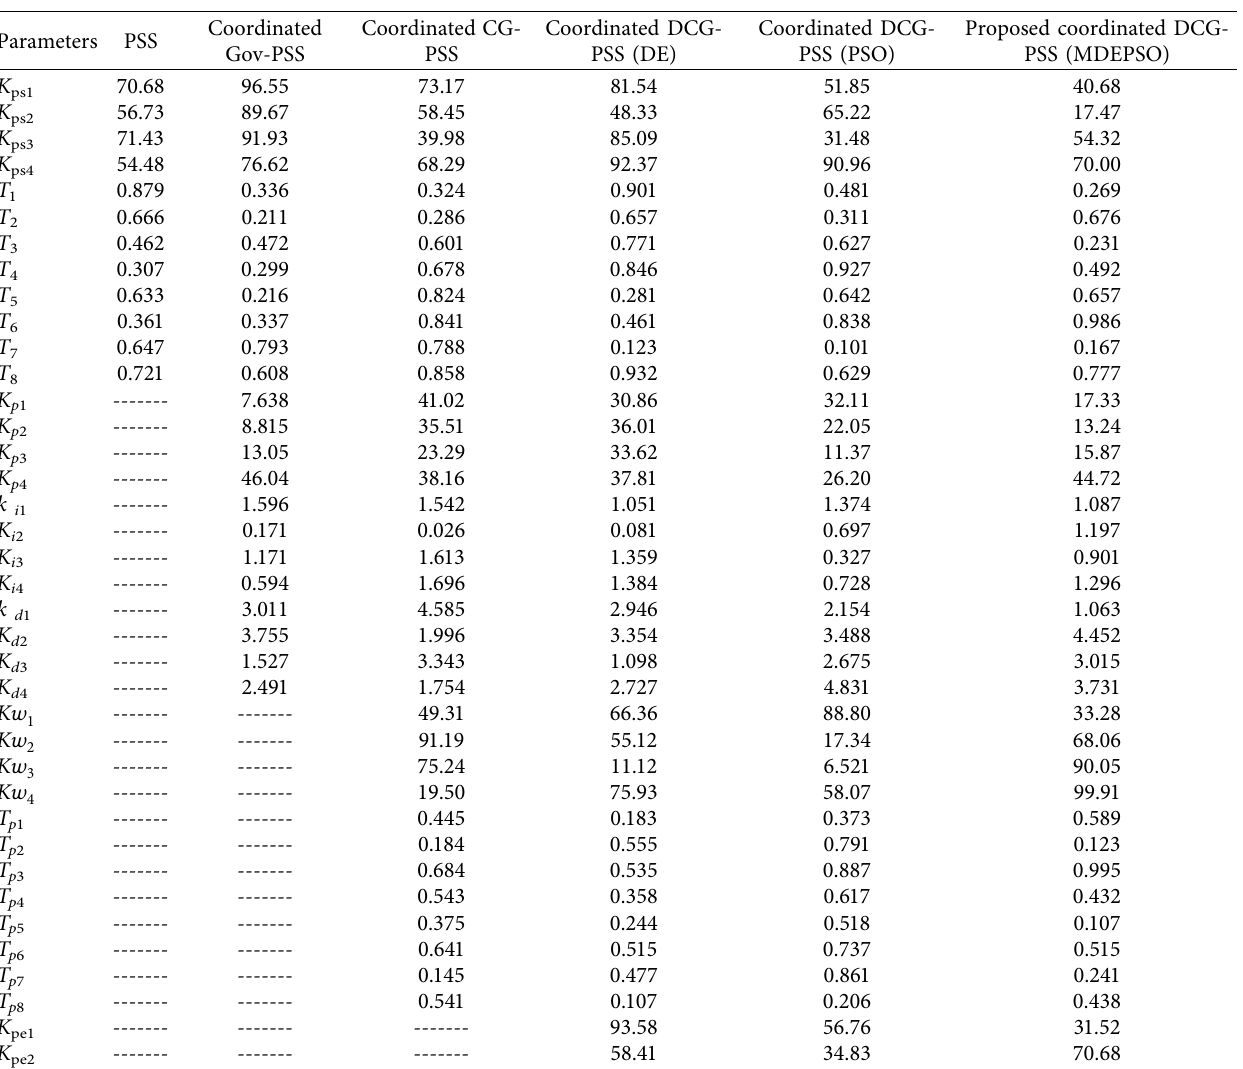
Table 6: Optimized